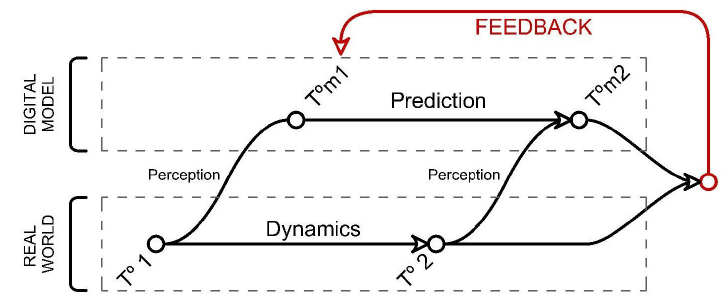
13 of 22 Figure 9. Final artificial neural network structure proposed. Phenotype, genotype, fitness, and mutation will decide and teach the system how to act in each situation (global behavior) but will also propose when to deploy the layer for solar gain control (Local cushion behavior). 4.4. Artificial Neural Network Definition The first decision for the learning behavior enables the membrane to decide in which scenario it is working in accordance with pre-trained scenarios. Then, the performance customization of the insulation layer is performed on-site through the internal environ- mental control procedure implemented. The proposed ANN will have 100 neurons in the input layer and 150 neurons in the hidden layer. Each one of those 100 neurons corresponds to the behavior and tempera-